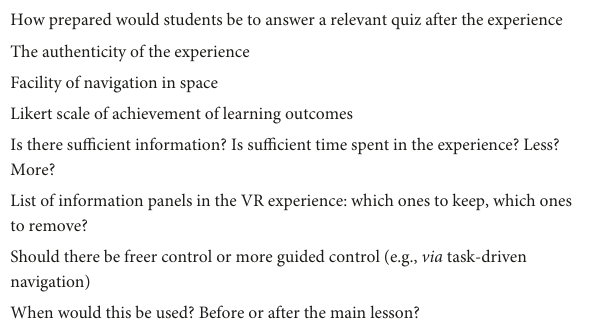
TABLE 1 Learning outcomes in history level 7. TABLE 2 Suggested evaluation criteria for final IVR